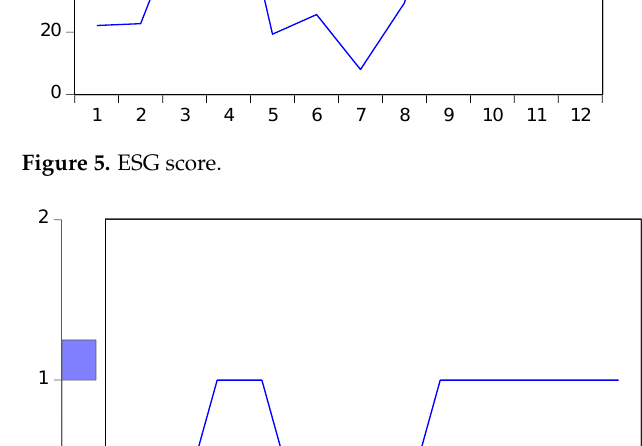
Figure 5. ESG score.